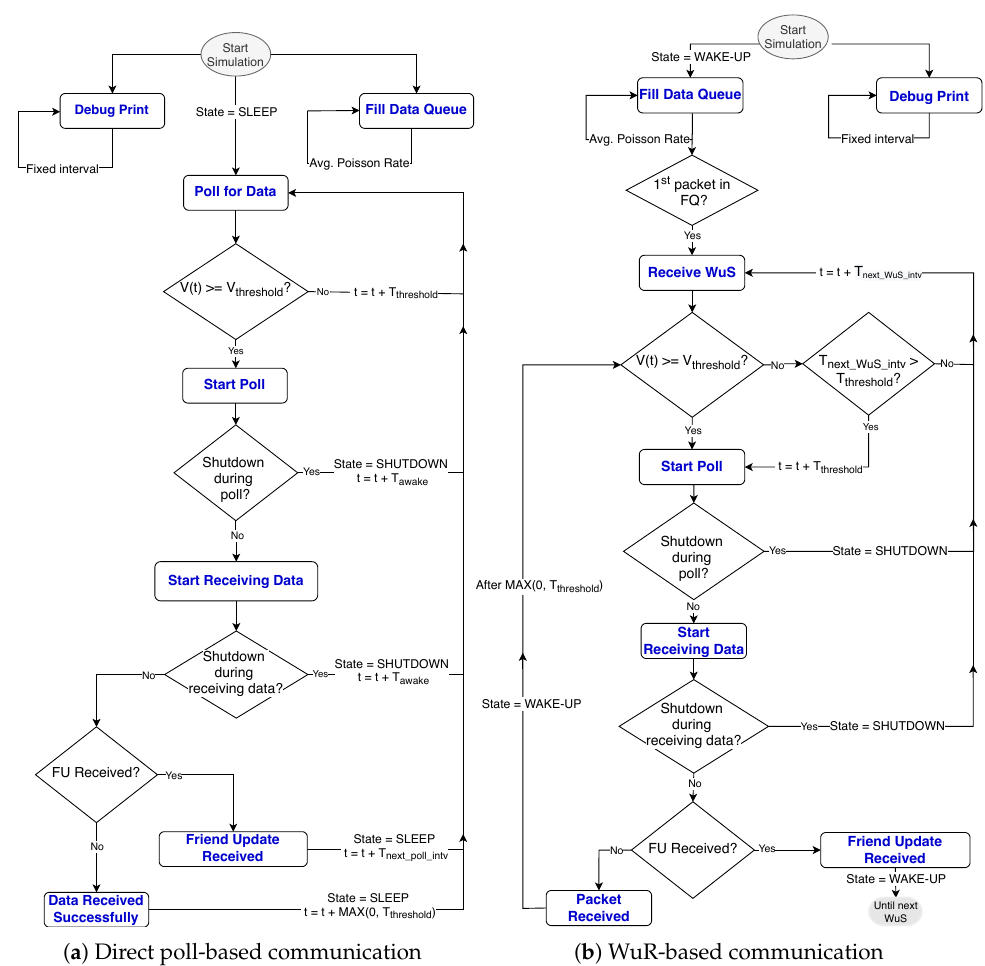
Figure 8. Flowchart of the simulator for batteryless LPN communication (V(t): Voltage of LPN